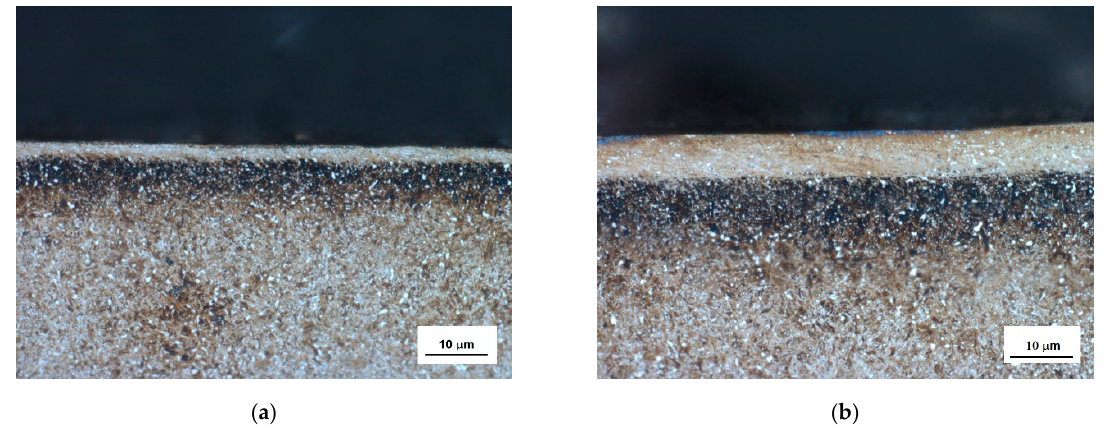
Figure 7. Optical images of milled surface: ( a ) VB = 0.6 mm, and ( b ) VB = 0.8 mm.